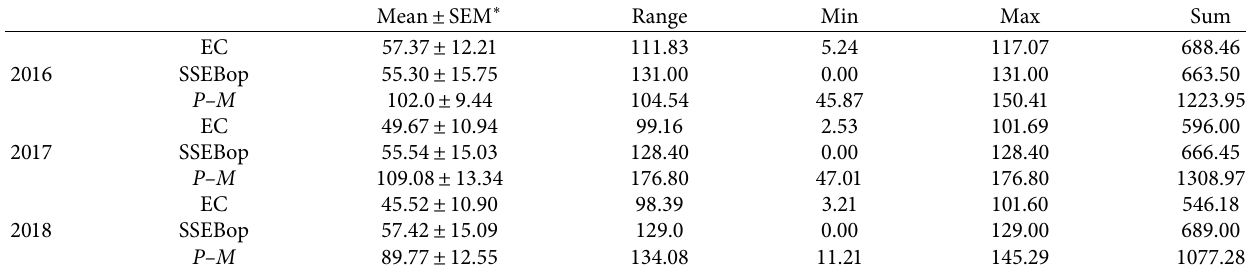
Table 1: Descriptive monthly statistics of evapotranspiration (mean ± SEM, range, minimum (min), maximum (max), and sum of ET measured (EC, eddy covariance), simplified surface energy balance (SSEBop) model, and reference Penman–Monteith ( P–M ) evapo- transpiration) for 2016, 2017, and